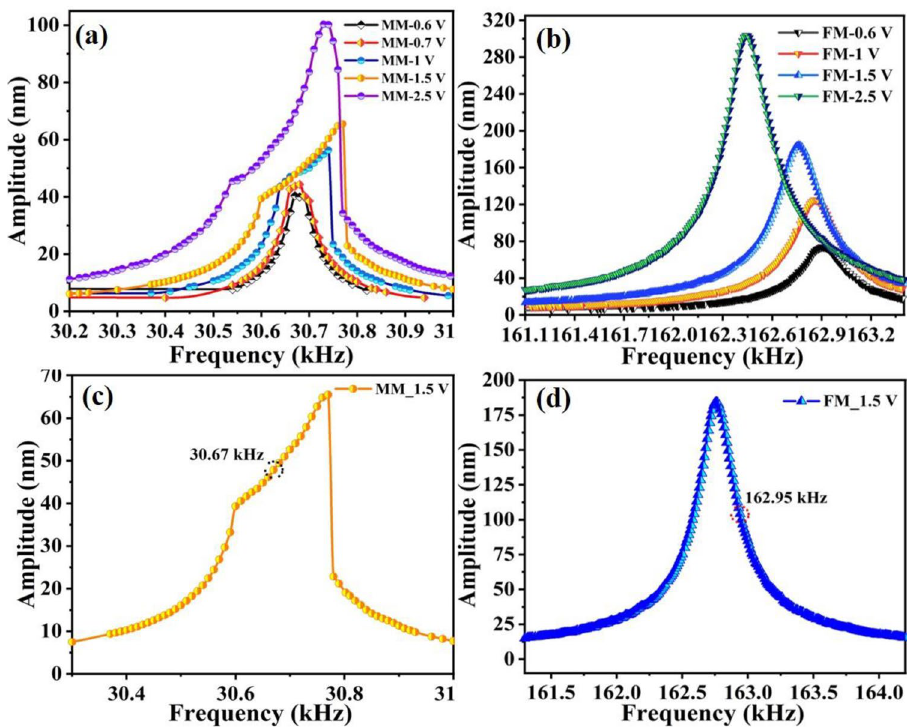
Figure 6. Frequency response curves for the resonator, ( a ) frequency sweep at mass mode under different operating voltages, ( b ) frequency sweep at flexural mode under different operating voltages, ( c ) mass mode frequency response obtained at V ac = 1.5 V encircled with the selected single frequency for actuation, and ( d ) flexural mode frequency response obtained at V ac = 1.5 V encircled with the selected single frequency for